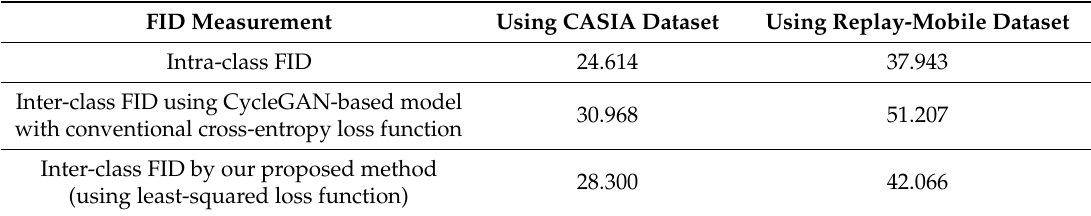
Table 6. FID measurements for the captured images versus generated images using our proposed method in comparison with intra-class FID and the model based on conventional cross-entropy loss